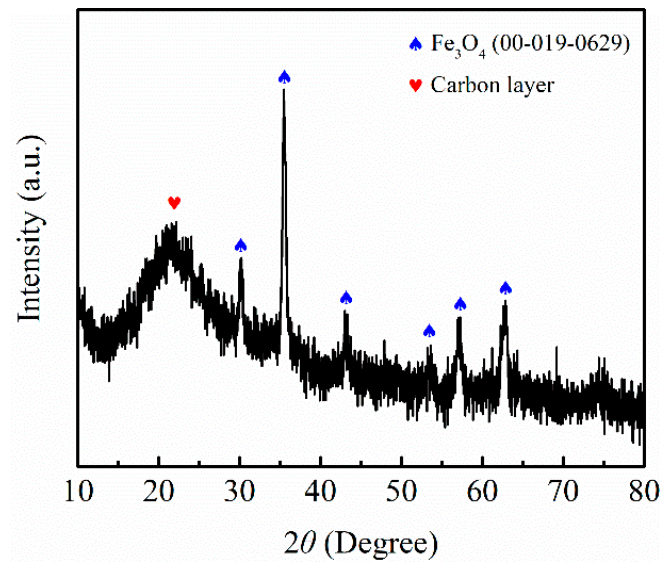
Figure 1. The XRD pattern of the Fe 3 O 4 @C nanoparticles. The HRTEM graphs presented in Figure 2a,b show that the morphology of the Fe 3 O 4 @C nanoparticles was spherical, with a core-shell structure. The primary parti- cle diameter was ~30 nm and the thickness of the carbon-shell was ~2 nm. Figure 2c demonstrates that the interlayer spacing of the lattice fringes was 0.26 nm, which closely matched the d-spacing of the (311) plane in cubic Fe 3 O 4 . The SAED micrograph shown in Figure 2d further verified the polycrystalline structure of the Fe 3 O 4 @C nanoparticles, where the diffraction rings could be ascribed to the (220), (311), (400), (511), and (440) planes of Fe 3 O 4 . The specific surface area of the Fe 3 O 4 @C nanoparticles, calculated by the BET method, according to the N 2 adsorption/desorption isotherm curves was 37.74 m 2 /g; see Figure S2a. The average pore diameters and pore volume estimated by the BJH method according to the pore distribution, displayed in the inset of Figure S2a, was 3.78 nm and 0.227 cm 3 /g, respectively. The magnetic property of the Fe 3 O 4 @C nanoparticles determined the ease of the separation of the particles in a heterogeneous solution. The magnetic hysteresis loops of the Fe 3 O 4 @C nanoparticles measured by the VSM at 298 K are displayed in Figure S2b, and showed a superparamagnetic feature. The saturation magnetization was 77 emu/g, which was lower than the values reported in the literature [52,53]. The lower saturation magnetization of the as-synthesized Fe 3 O 4 @C nanoparticles might have been due to the coating of the carbon-shell. The coercivity value was found to be only 0.16 kOe and the remnant magnetization was 12.8